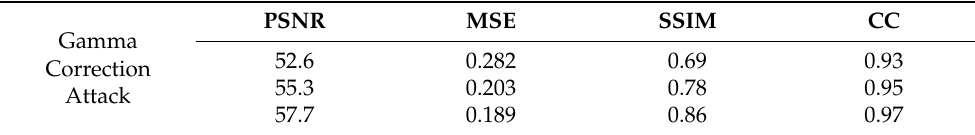
Table 4 expresses the value of performance metrics of the stego file for gamma correction attack. The average value of PSNR is calculated as 55.2 dB, the average value of MSE is 0.228 dB 2 , the average value of SSIM is 0.77, and the average value of CC is 0.95. The lower value of MSE means less is the error present between original and stego file. Higher value of PSNR, CC and SSIM represent good quality of stego file. High value of these three parameters means a lower chance of exposure of secret message. Table 4. Performance Metrics for Gamma Correction.